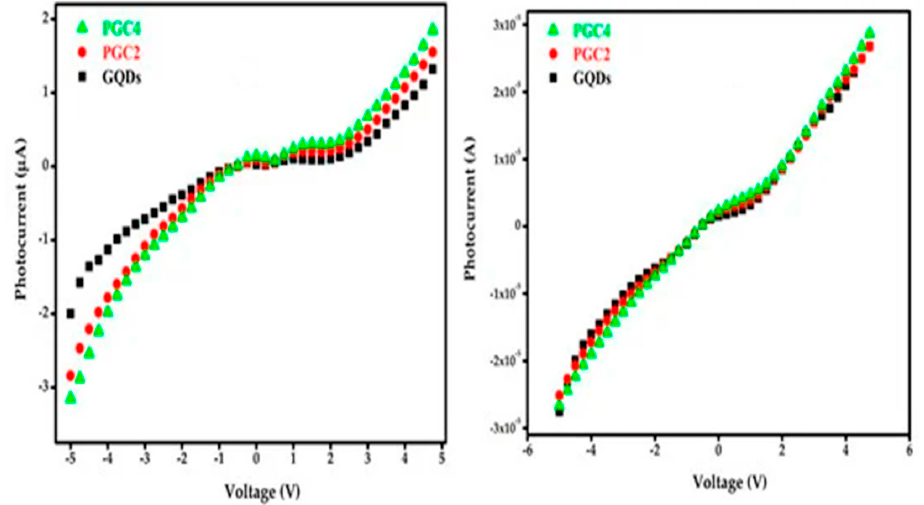
Figure 4. Comparison between the photocurrents of three photodetector devices under illumination [110]. tion PGC2 and PGC4 show responsivity of about 0.33 μ A/W and 0.36 μ A/W and corre- sponding photocurrent of 2.65 μ A and 2.9 μ A when illuminated at wavelength 265 nm, while a responsivity of 1.93 and 2.33 μ A/W and photocurrent of 15.5 μ A and 18.7 μ A was